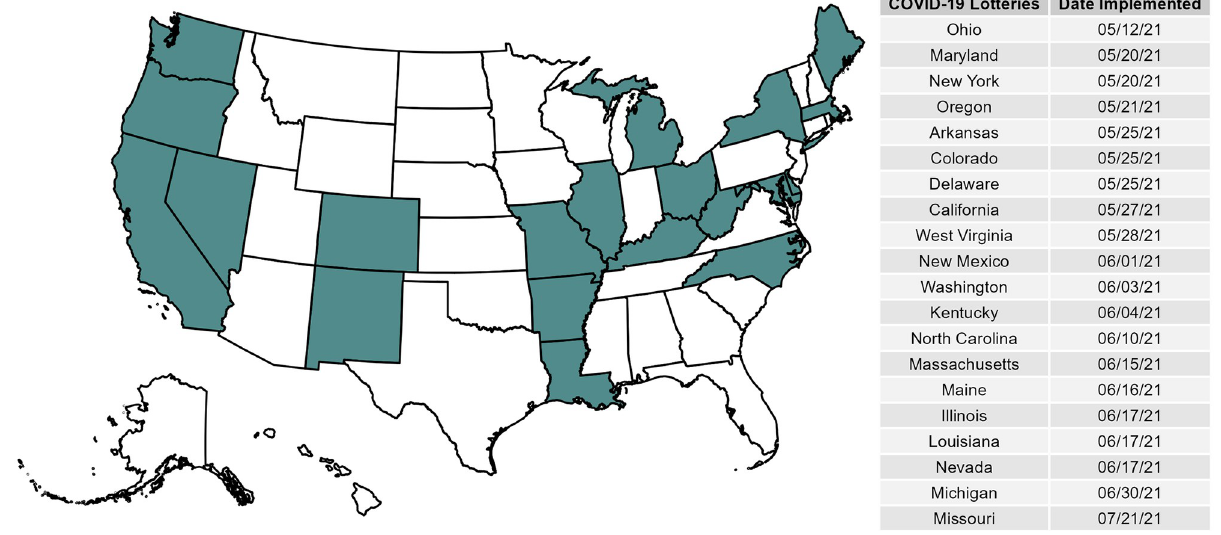
Fig 1. Map and table of states that conducted COVID-19